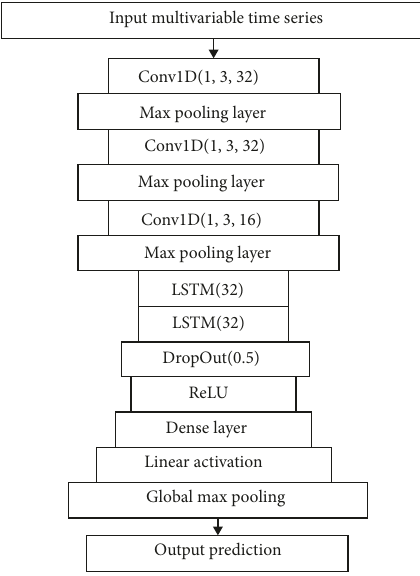
Figure 6: CNN-LSTM hybrid